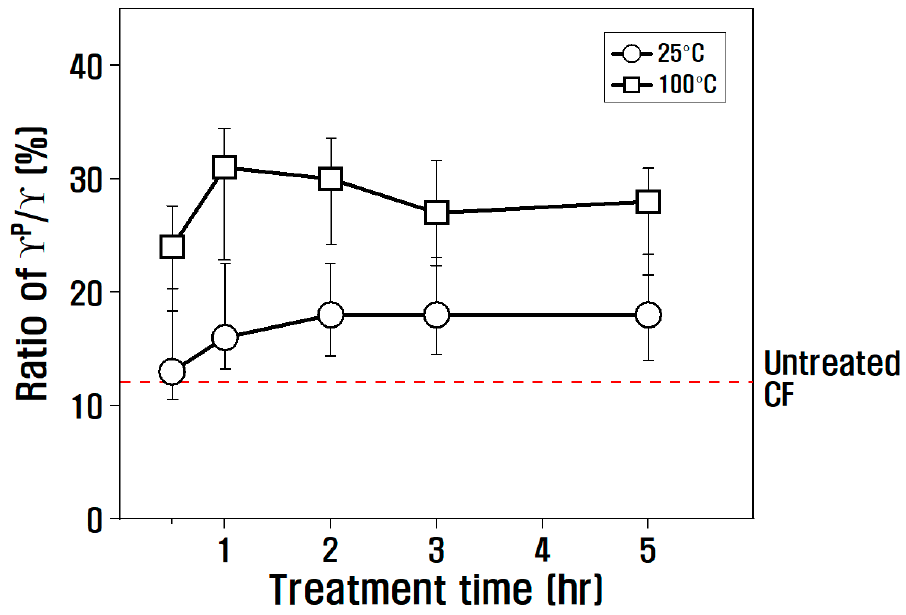
Figure 7. Variation of 𝛾 (cid:3017) /𝛾 according to chemical treatment conditions.